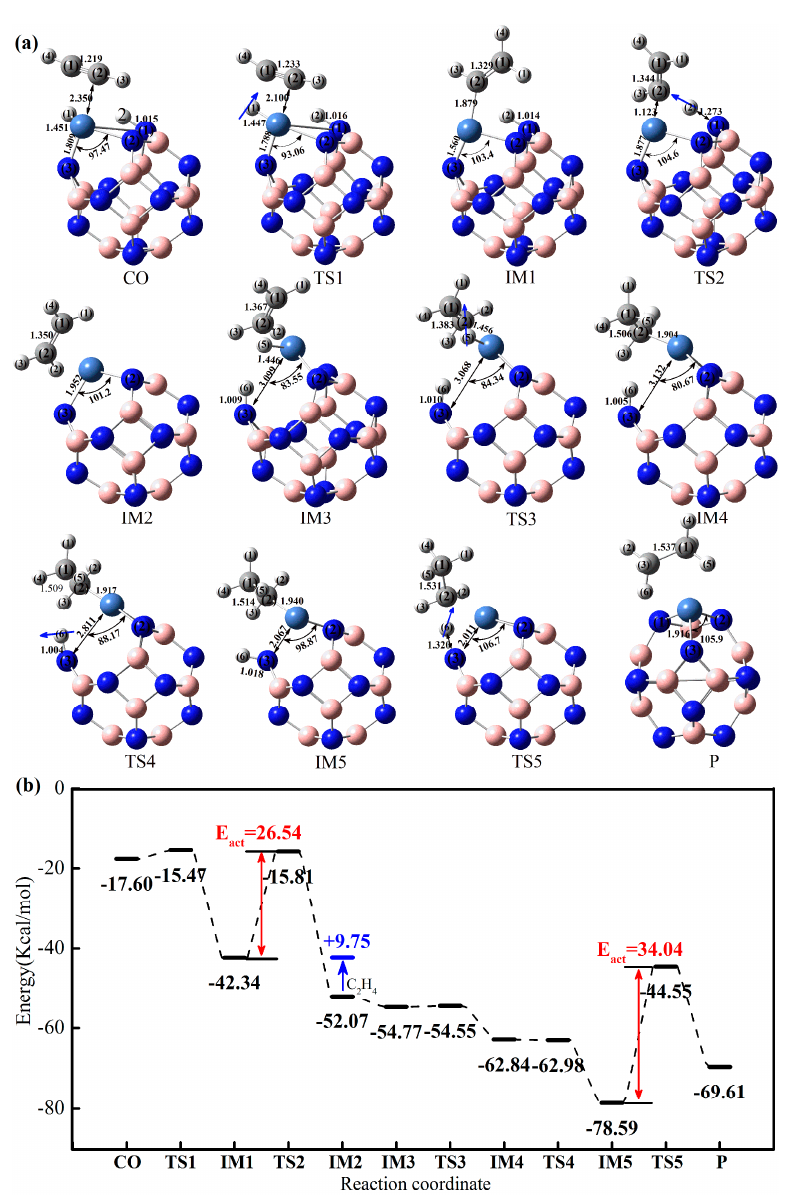
Figure 7. ( a ) The structures of calculated hydrogenation reaction diagram for the B 11 N 12 Ni. ( b ) The reaction process and potential energy change of catalytic hydrogenation of ethylene to ethane on the B 12 N 11 Ni. H atom is white; B atom is pink; C atom is grey; N atom is mazarine; Ni atom is blue.